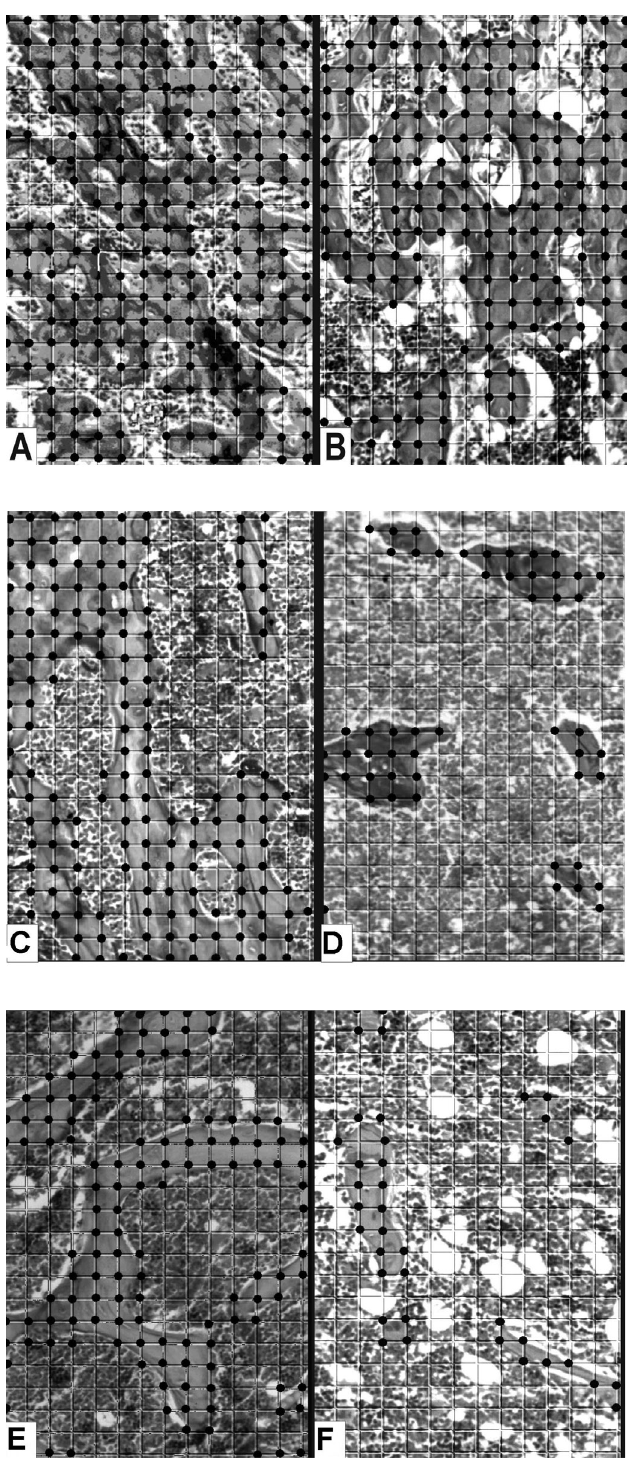
FIGURE 1- Simultaneous demonstration of trabecular separation, trabecular thickness, and trabecular bone volume in femur sections of control rats (A, C, E) and diabetic rats (B, D, F), on day 5 (A, B) after induction of experimental diabetes, on day 45 (C, E) and day 120 post-onset of experimental diabetes. H&E,